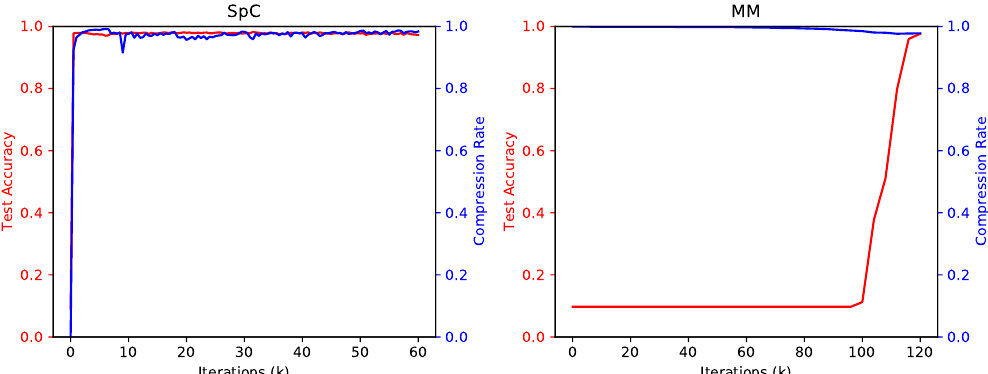
Figure 8. Convergence behavior of the our method SpC (left) and the state-of-the-art MM (right) in terms of compression rate and test accuracy on Lenet-5 (MNIST). Our method SpC reaches top accuracy and compression much faster than MM. Note that the last iterations are 60k (SpC) and 120k (MM).